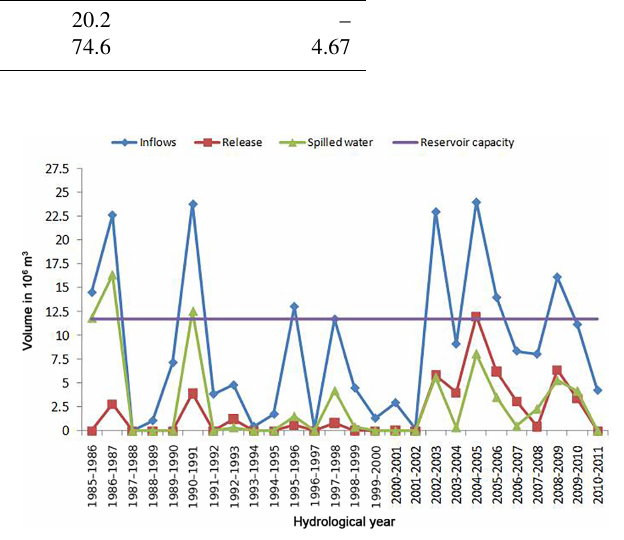
Figure 6. Annual inflows, release and spilled water at Ghézala dam